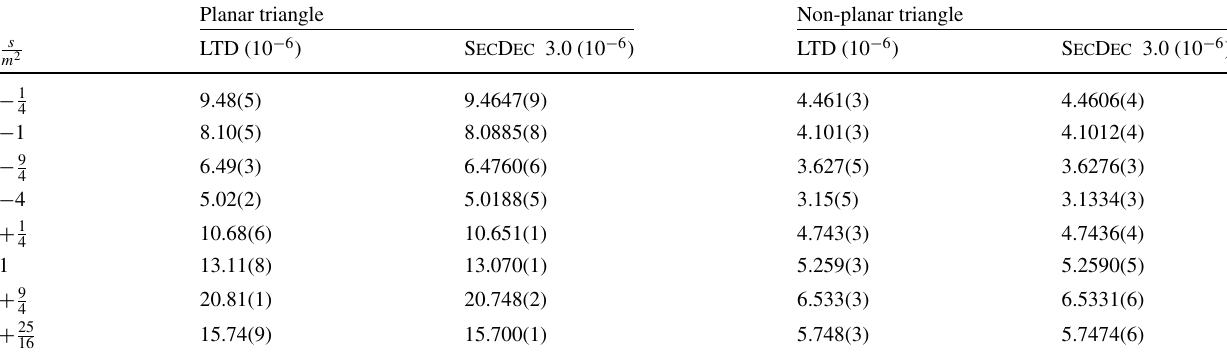
Table 1 Numerical integration with NIntegrate of the planar and non-planar two-loop triangles of Fig. 6 in the causal representation. The values of the integrals are compared with SecDec 3.0 Planar triangle Non-planar